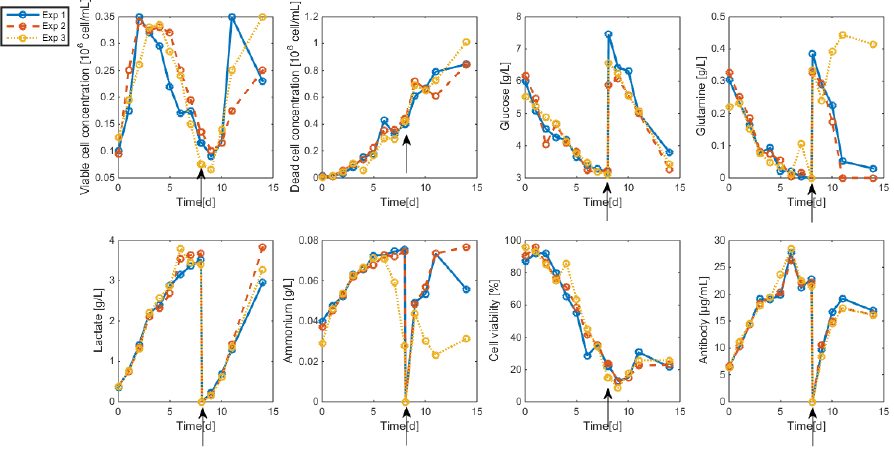
Figure 2. HB1 sequential batch culture data sets. Medium refreshment times are indicated by the arrows. Bioengineering 2017 , 4 , 17